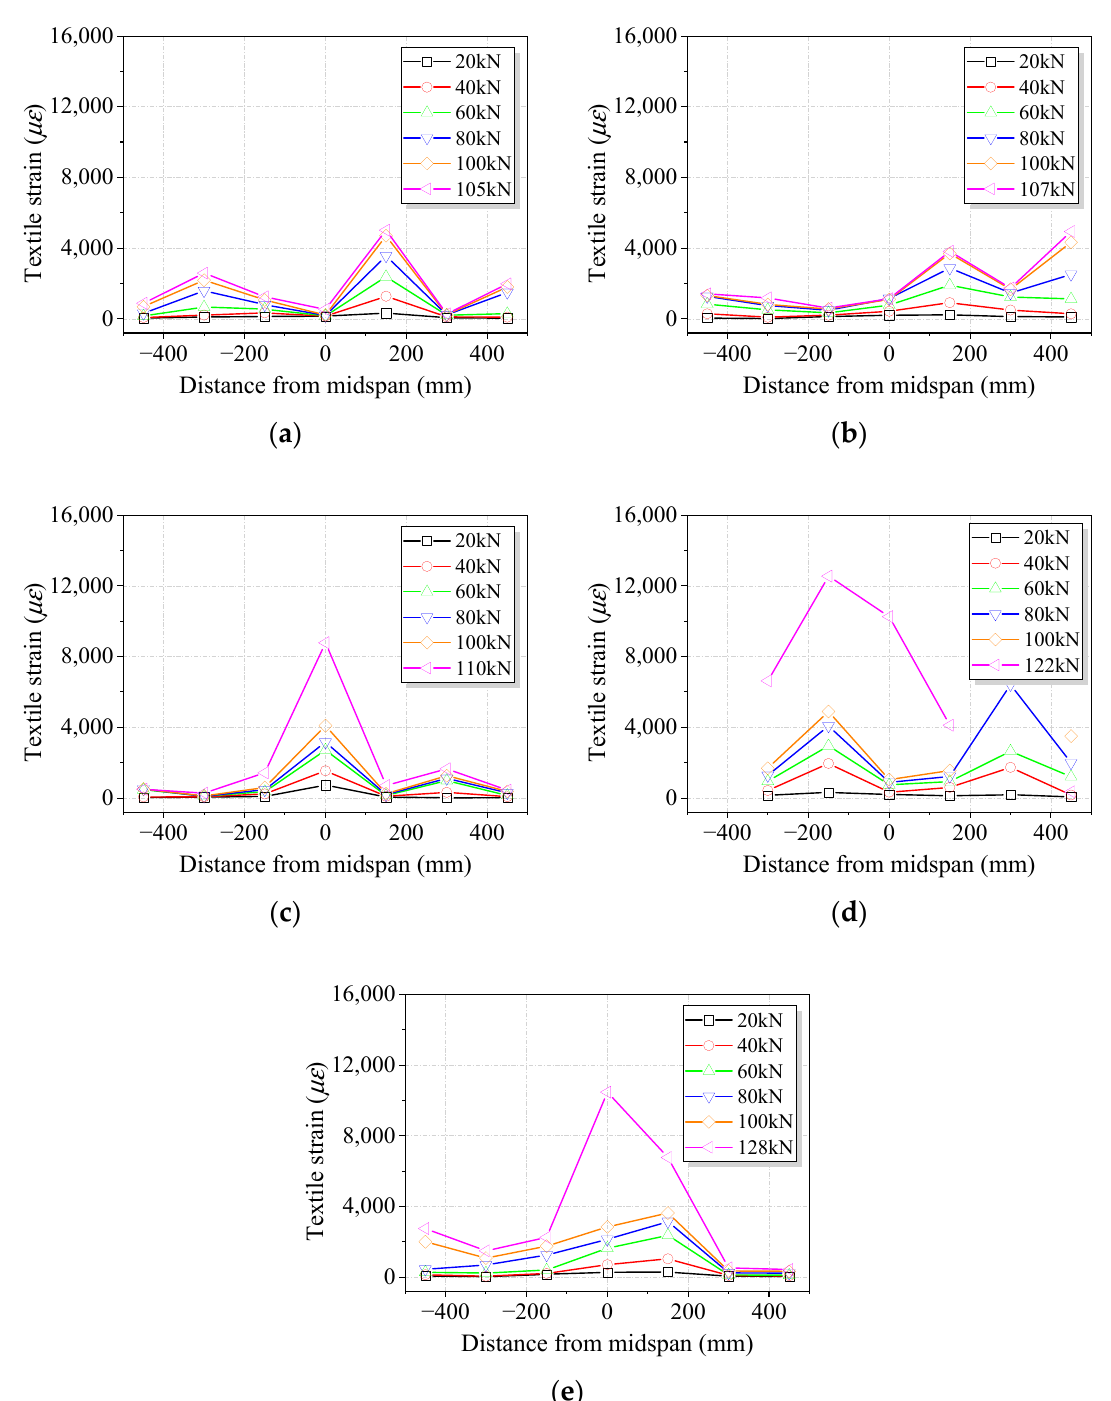
Figure 11. Strain profiles of basalt textile for strengthened beams. ( a ) B1. ( b ) B3. ( c ) B3E. ( d ) B5. ( e ) B5E.